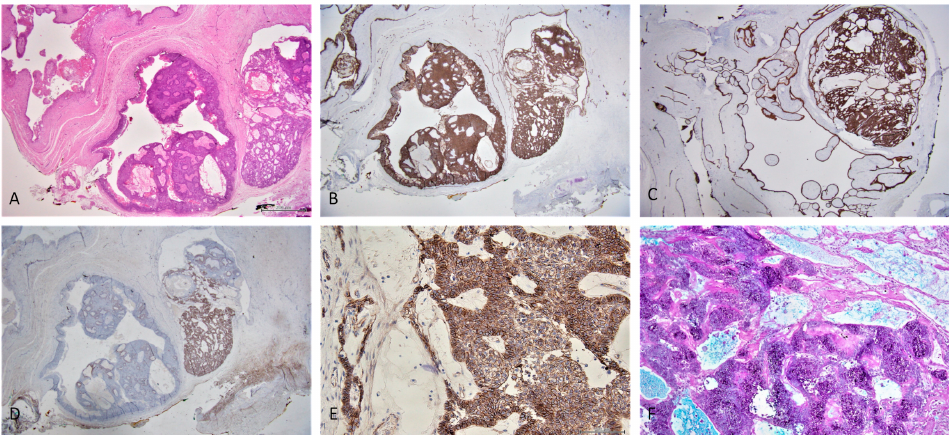
Figure 6. An H and E-stained section ( A —magnification × 12.5) and immunohistochemical stain- ing of a case of solid/multicystic/conventional ameloblastoma, showing expression of CK19 ( B —magnification × 12.5), CK5/6 ( C —magnification × 12.5), CD56 ( D —magnification × 12.5), mem- brane expression of beta-catenin ( E —magnification × 200) and histochemical staining AB-PAS ( F —magnification × 100).